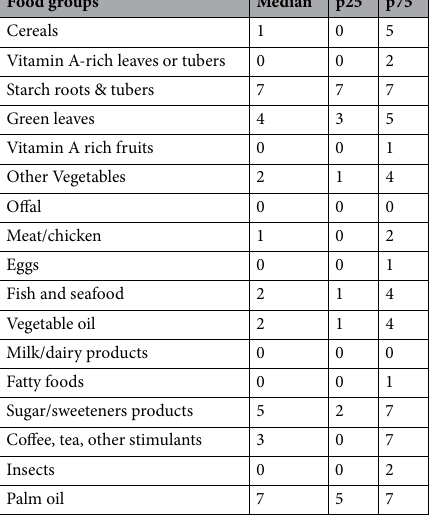
Table 2. Food consumption characteristics are expressed as the number of days on a week scale the child consumed at least one item of the food groups.